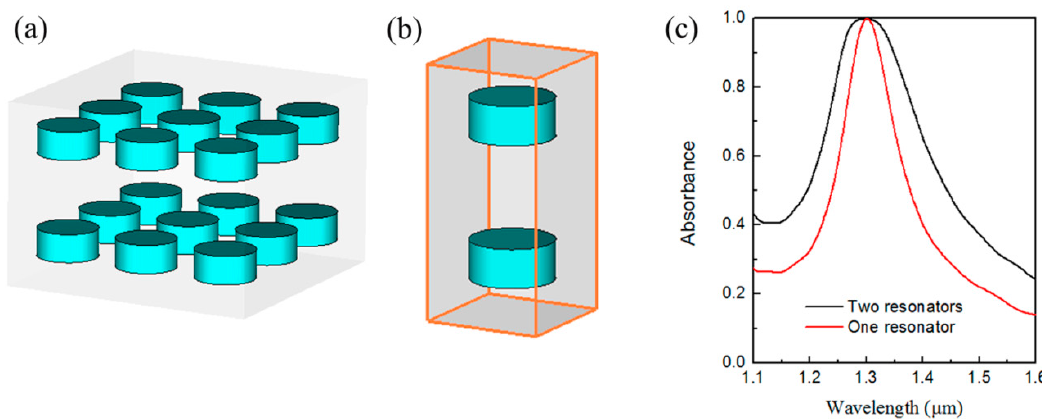
Figure 3. Schematic representation of the proposed broadband all-dielectric metasurface structure and its absorbance spectrum. ( a ) Periodic array and ( b ) unit cell structure of the metasurface, where the unit cell is composed of two coupled silicon disks embedded in silicon dioxide. ( c ) Numerically calculated absorbance spectra of the double resonator unit cell (black line) and the single resonator unit cell (red line), where the latter is provided for comparison.